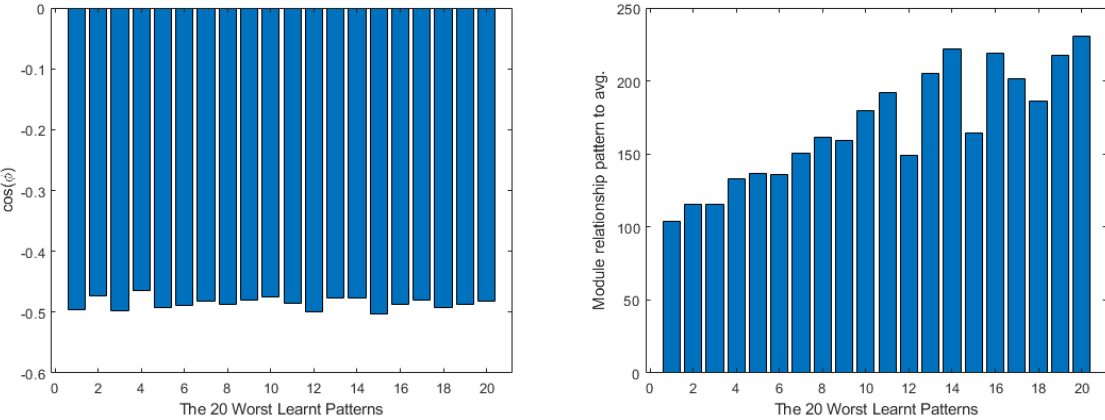
(cid:12) (cid:12) 𝜕𝐿𝑜𝑠𝑠 ∂ Loss (cid:12) (cid:12) | relationship to the average (cid:12) (cid:12) relationship to the average ∂ W n 𝜕𝑊 𝑛